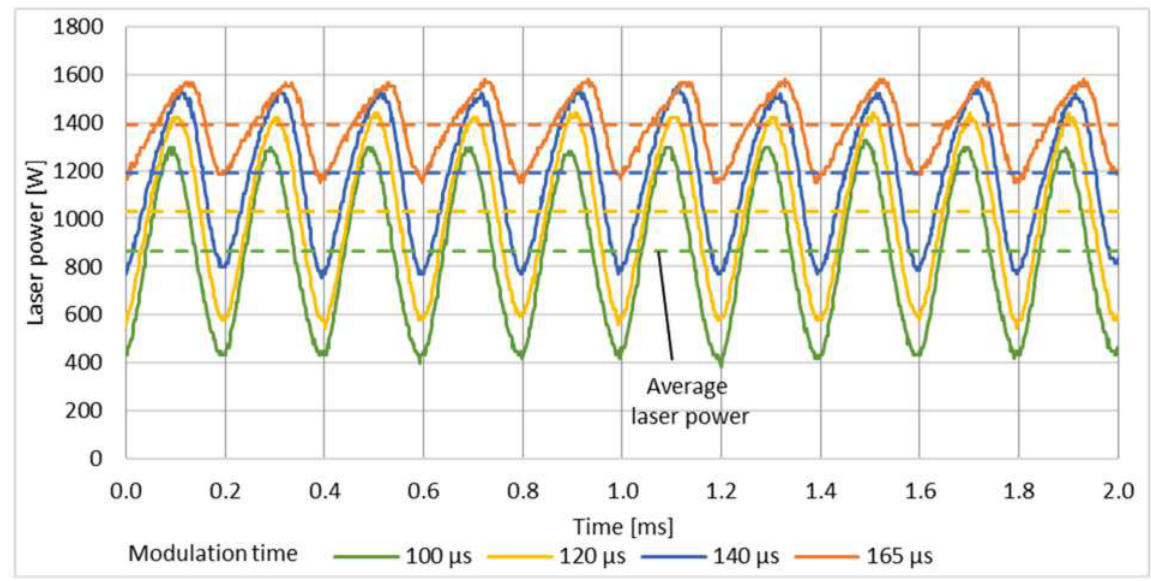
Figure 8. Modulation behaviour at varying modulation time t m at a modulation frequency f m of 5